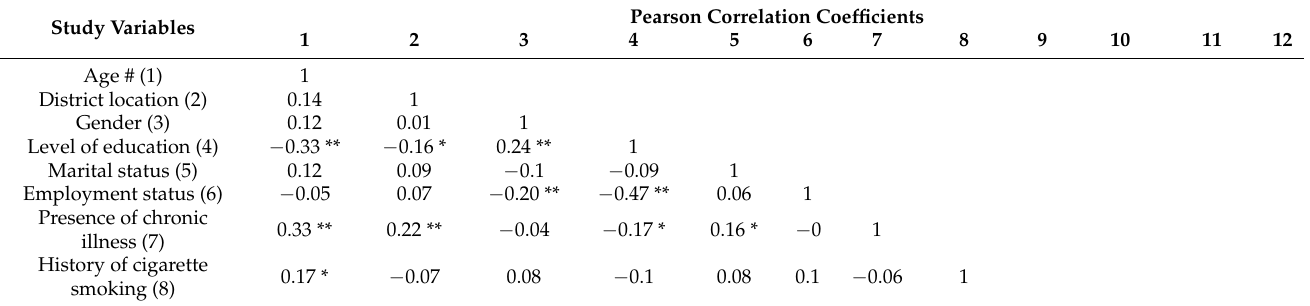
Table 3. Correlations between the total number of BPSD and other variables